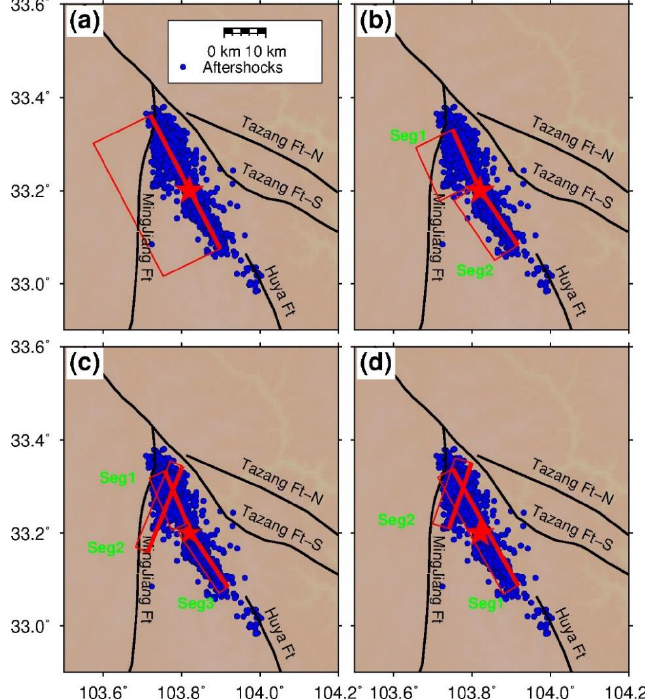
Figure 2. Projections of the four finite fault models on the surface, including the ( a ) one-fault model, ( b ) two-fault model (a northern fault and a southern fault), ( c ) three-fault model, and ( d ) brand-new two-fault model (a main fault and a secondary fault). Other symbols are the same as Figure 1b.